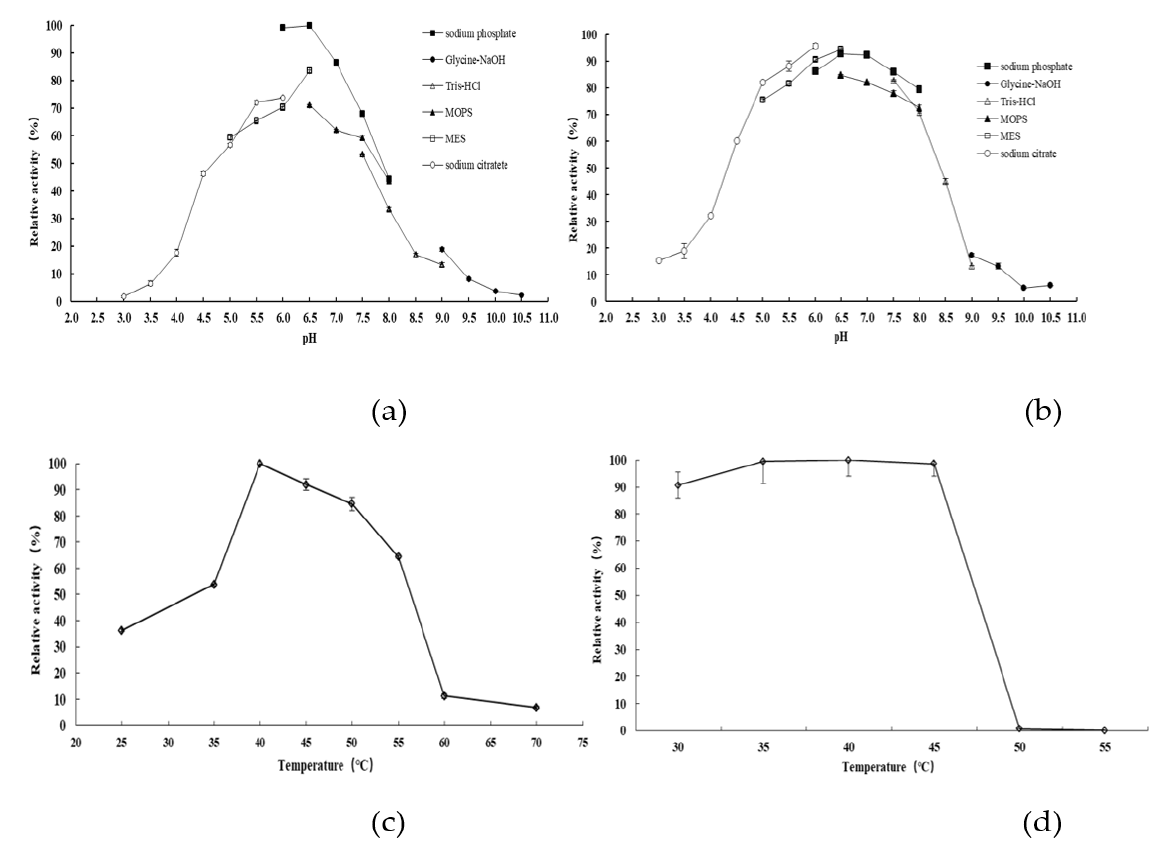
Figure 3. pH and temperature profiles of AlFFase3. Effect of pH on activity ( a ) and stability ( b ) was performed at 40 °C in 50 mM different buffers: sodium citrate ( ○ ), MES (□ ), sodium phosphate ( ■ ), MOPS ( ▲ ), Tris-HCl ( (cid:52) ), and glycine-NaOH ( • ). The remaining activities were measured after incubation for 30 min at 40 °C, over various pH ranges. Effect of temperature on the activity ( c ) and thermostability ( d ) of AlFFase3 were determined at temperatures ranging from 25 °C to 70 °C in 50 mM sodium phosphate buffer (pH 6.5).